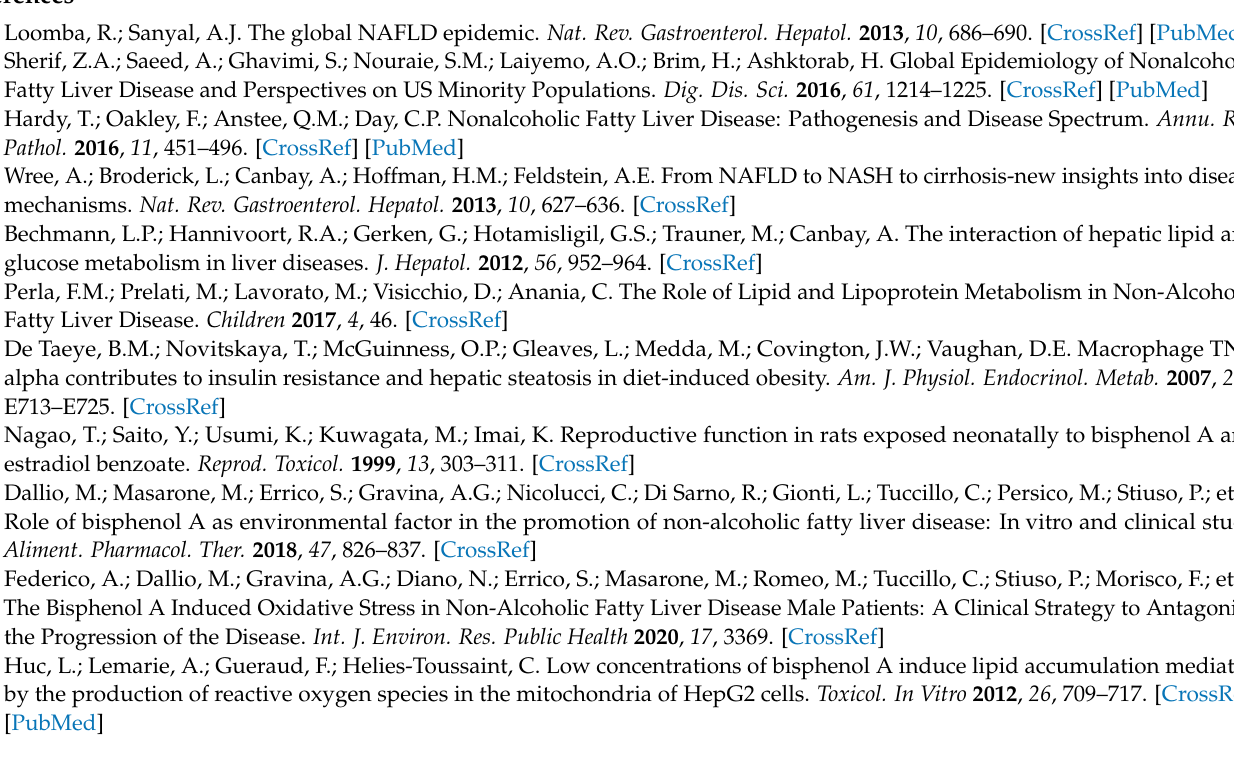
of the manuscript. (b) Original unedited blot, ECL images indicating CD36 and α -tubulin for representative Western blots used in Figure 4b of the manuscript; Figure S2: Original unedited blot, ECL images indicating CD36, C/EBP α , CHOP and α -tubulin for representative Western blots used in Figure 4c of the manuscript; Figure S3: (a) Original unedited blot, ECL images indicating CHOP and α -tubulin for representative Western blots used in Figure 5b of the manuscript. (b) Original unedited blot, ECL images indicating CD36 and β -actin for representative Western blots used in Figure 5c of the manuscript. (c) Original unedited blot, ECL images indicating α -SMA and α -tubulin for representative Western blots used in Figure 5d of the manuscript. (d) Original unedited blot, ECL images indicating CL-caspase 3 and α -tubulin for representative Western blots used in Figure 5d of the